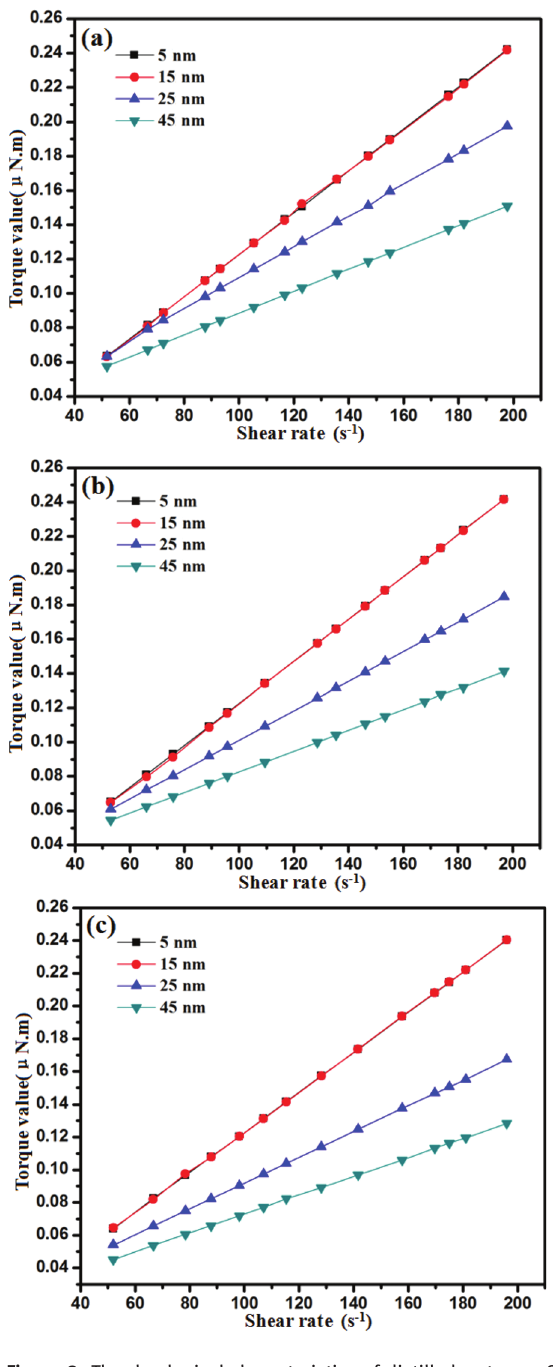
Figure 8: The rheological characteristics of distilled water on CNTs prepared with different thickness of nickel films (a) D = 500 μ m, (b) D = 600 μ m, (c) D = 700 μ